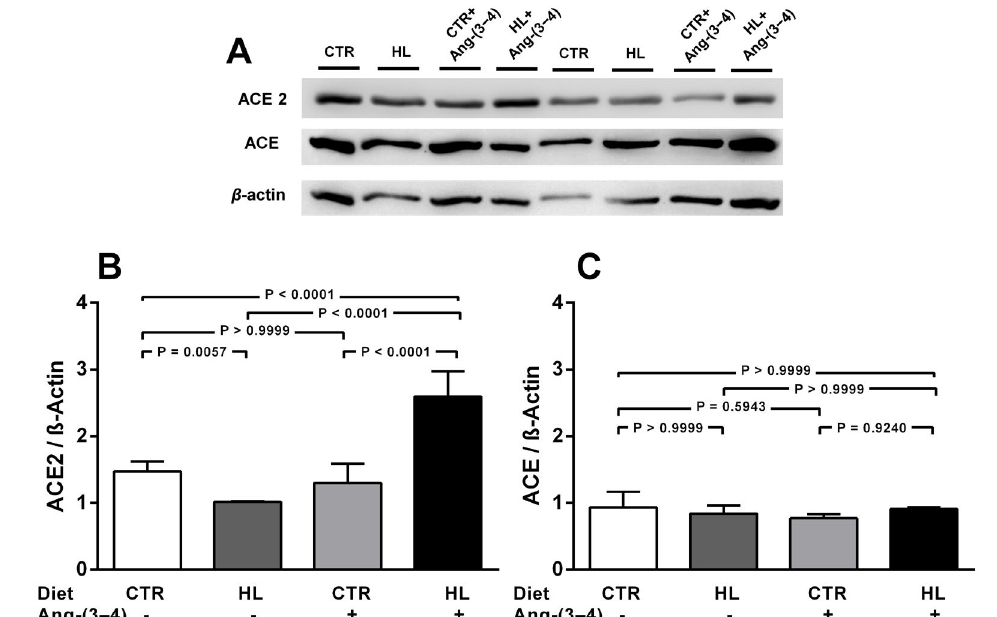
Figure 2. Overweight downregulates ACE2, but not ACE, in adult rats on a HL diet. Effects of Ang-(3-4). A. Representative immunoblottings from renal cortex corticis of control and overweight adult rats; β-actin was used as the loading control; B and C. bargraph representation of ACE2 and ACE levels in renal cortex corticis . Bars indicate mean ± SEM ( N = 4-8 different membrane preparations). Combinations of diets and Ang-(3-4) administration as indicated above the gel and on the abscissae. Statistical differences were estimated using one-way ANOVA followed by Bonferroni’s test for the selected pairs indicated within the panels. Significant differences were set at P < 0.05. In A, the figure shows bands from the same gel